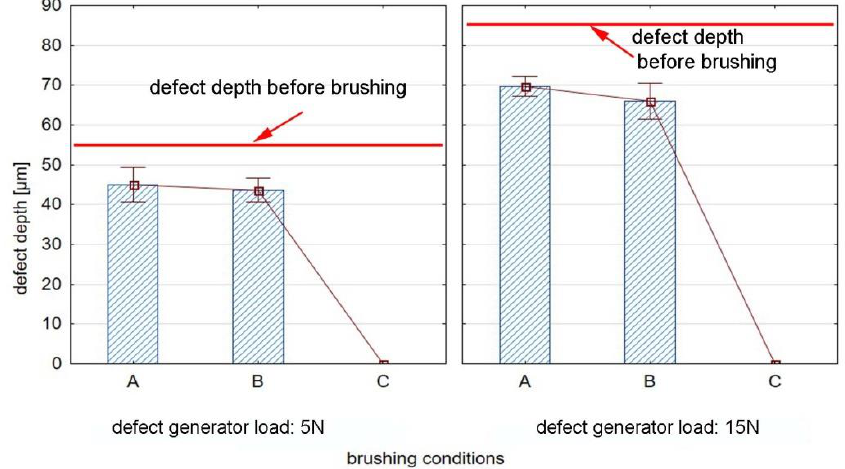
Figure 10. Effect of brushing conditions on defect depth for EN AW 2024 aluminum alloy.